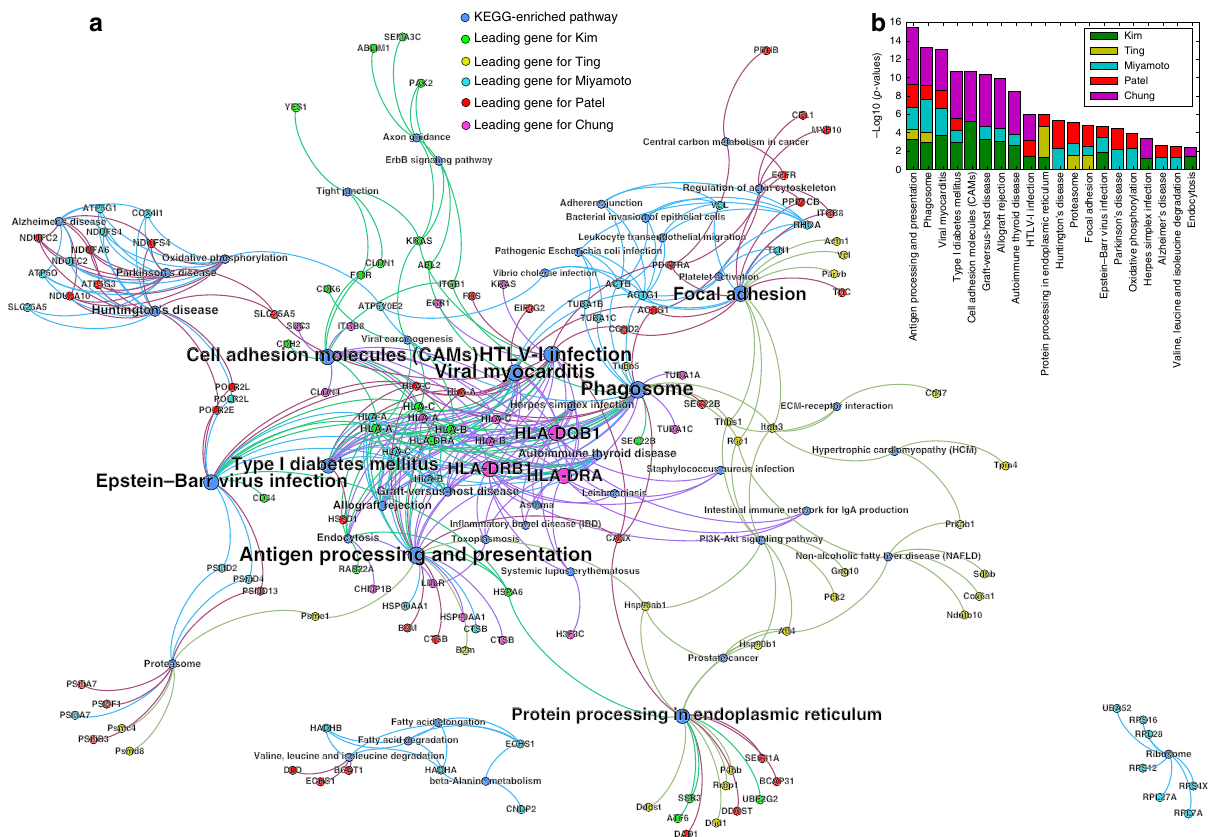
Fig. 5 Gene and KEGG pathways enriched with eeSNVs in the fi ve scRNA-seq datasets. a Bipartite graph using signi fi cant KEGG pathways and genes enriched with eeSNVs as nodes. An edge exists between a signi fi cant pathway and a gene if this gene is part of the pathway. Genes of each data set is represented with a distinct color. The size of the nodes re fl ects the gene and the pathway scores. The gene scores are computed by SSrGE and the pathway scores are the sum of the gene scores linked for each pathway. b KEGG pathways enriched within the top 100 genes based on eeSNV contributions in the fi ve datasets. Pathways are sorted by the sum of the − log10 ( p -value) of each dataset, in the descending